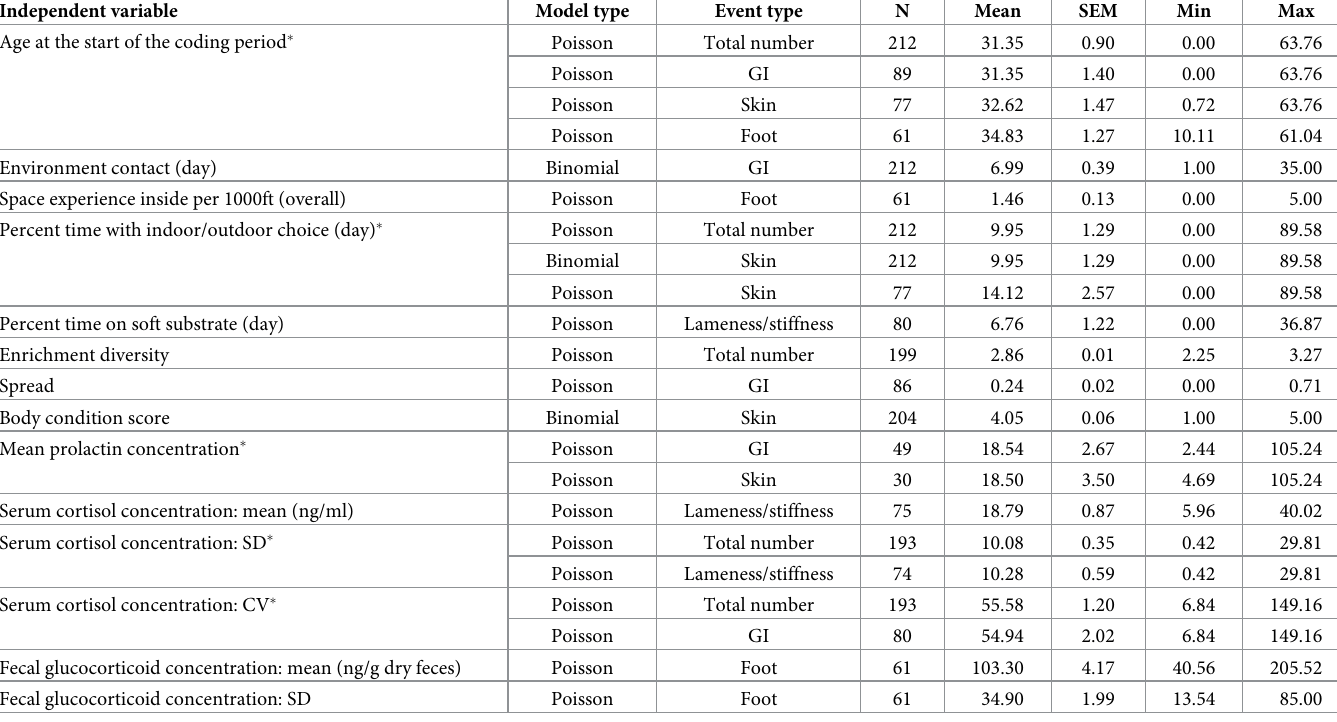
Table 6. Descriptive statistics (N, mean, standard error of the mean [SEM], minimum and maximum) for significant variables retained in final multivariate models, either for the total number of clinical events per animal (Poisson model), or for the individual number of gastrointestinal, skin lesion, lameness/stiffness and foot lesion event types per animal (binomial and/or Poisson model